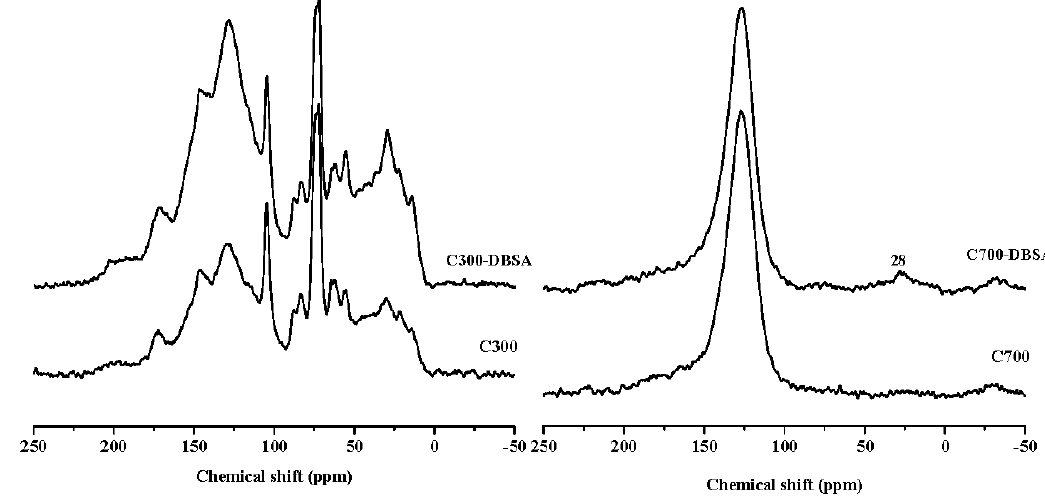
Figure 7. 13 C-NMR spectra of crop straw biochars, and their interaction complexes.